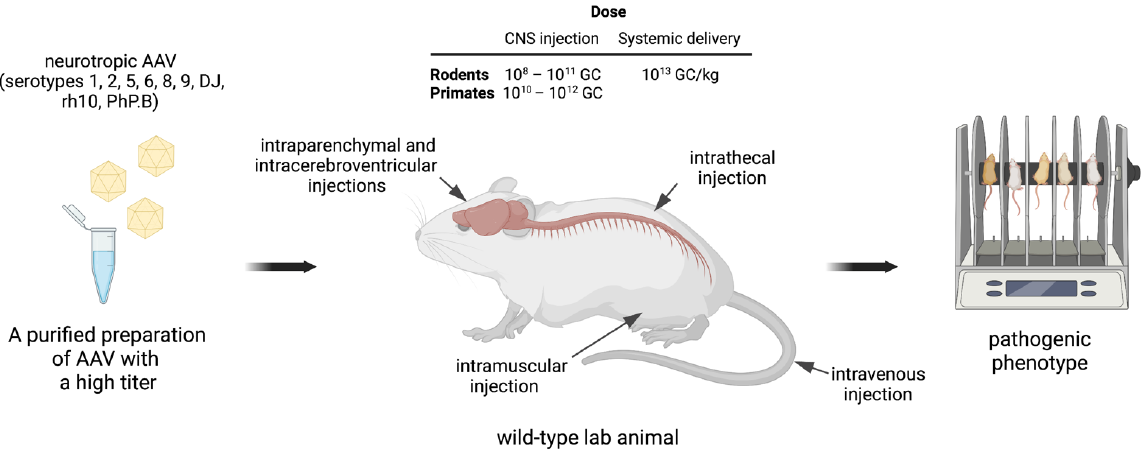
Figure 3. Creating models of human neurological disorders by targeting the CNS of wild-type laboratory animals with AAV. The most critical steps include obtaining custom-designed neurotropic rAAV, virus administration into a laboratory animal at a selected dose and by the optimal route, and observing the phenotype after the disease onset. Neurotropic serotypes of AAV and routes of administration used by researchers to model neurological diseases in rodents and primates are exemplified. The doses of AAV used for CNS injections and systemic delivery are shown. GC/kg, genome copies per kilogram of the body weight.